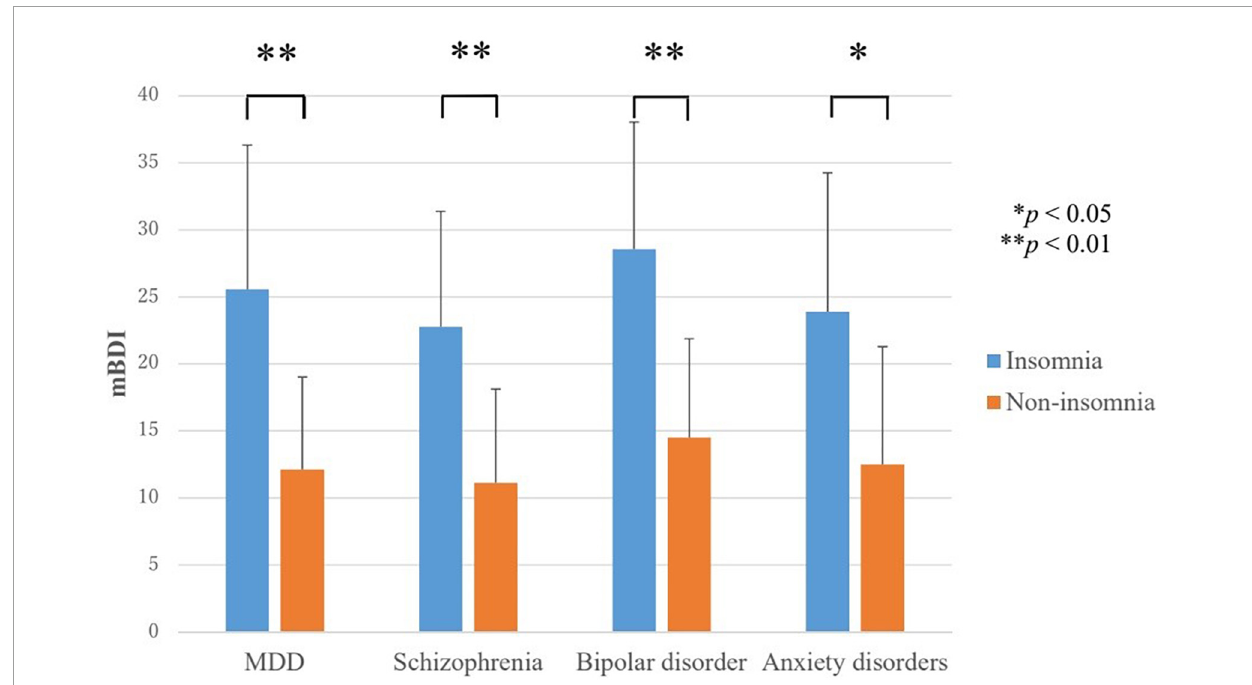
FIGURE1 Severity of depressive symptoms in the insomnia and non-insomnia groups as defined by Athens insomnia scale scores. MDD, major depressive disorder; mBDI, modified beck depression inventory. In all disorders, the score for depressive symptoms (mBDI) were higher in the insomnia group than in the non-insomnia group. ∗ P < 0.05, ∗∗ P <